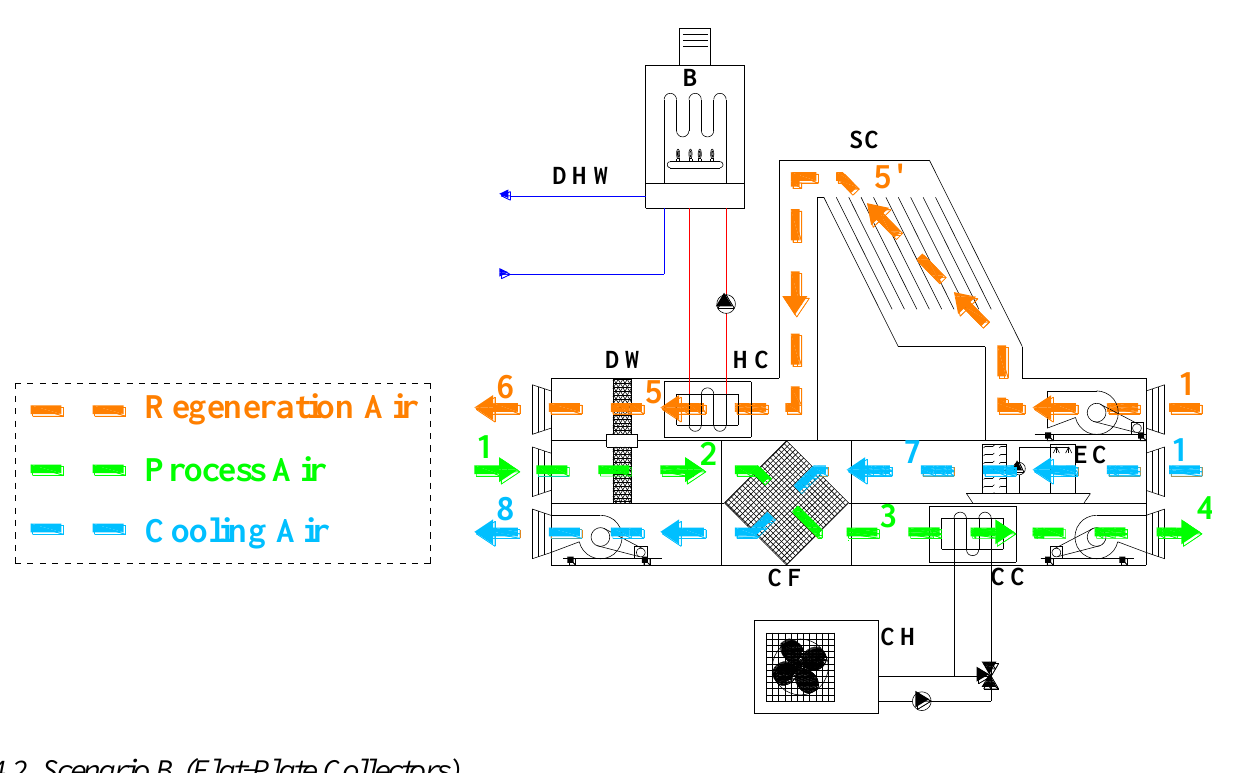
Figure 3. AHU layout for scenario A (air